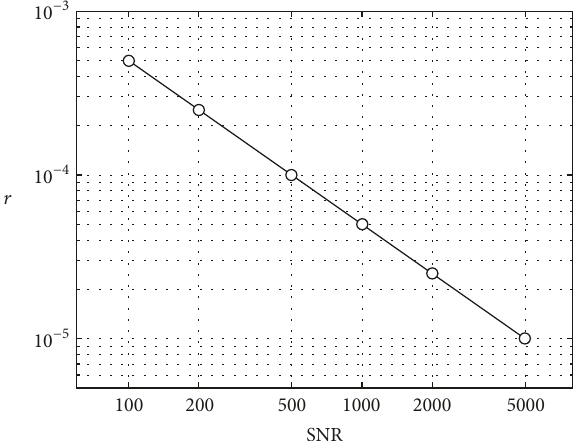
Figure 11: Values of the parameter 𝑟 that allows for crack detection for different levels of SNR in the